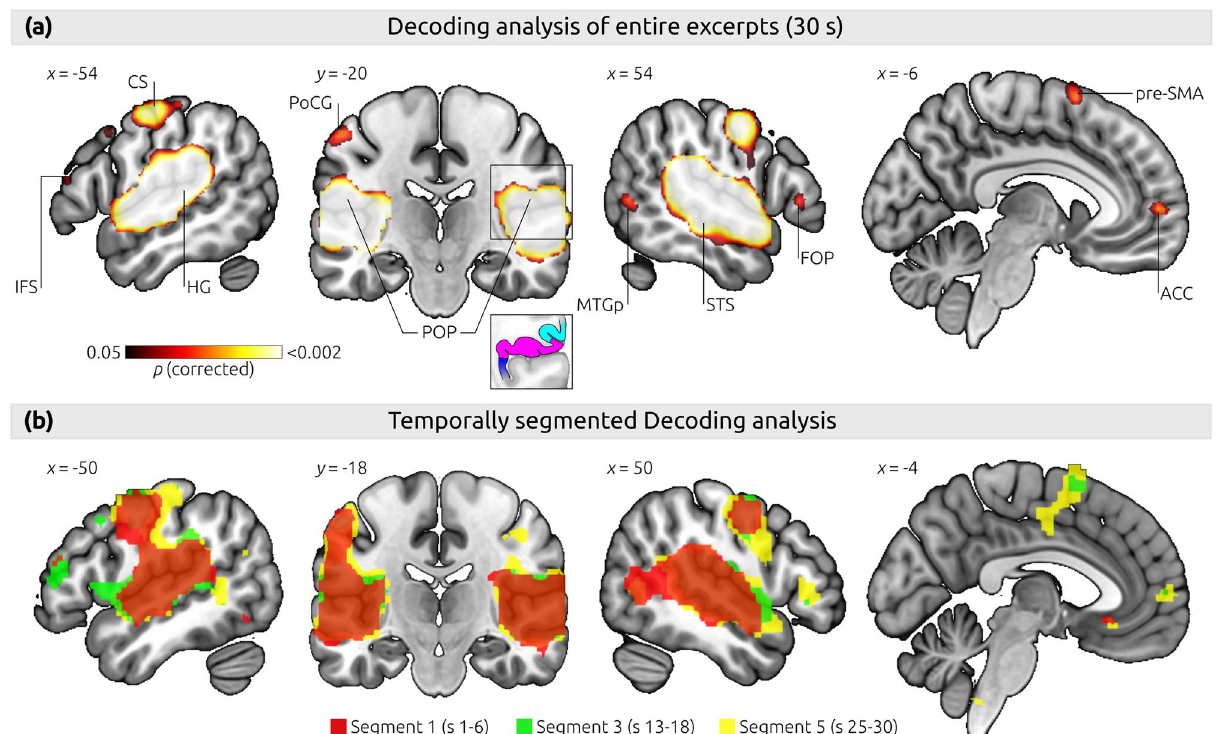
Figure 2. Results of the decoding analysis, showing clusters with voxels providing significant information about the difference between joy- and fear-music (after permutation-based t -tests and correction for multiple comparisons, all results were obtained without spatial smoothing, and statistical significance was computed on the voxel level). Results shown in the upper panel (a) were obtained using the entire duration of each music stimulus (each stimulus had a duration of 30 s). Significant clusters were found in the auditory cortex (including the superior temporal gyrus and superior temporal sulcus), posterior insular cortex, secondary somatosensory cortex (parietal operculum), primary somatosensory cortex and premotor cortex (post- and precentral gyrus as well as pre-SMA), frontal operculum and inferior frontal sulcus, as well as the ACC. The square in the coronal view indicates the area of the inset underneath; the inset illustrates anatomical boundaries between insula cortex (blue), cortex of the parietal operculum (magenta), and inferior parietal cortex (cyan), according to Ref. 50 . Note that the acoustical features that differed between joy and fear stimuli were entered as regressors of no interest in the data analysis, to reduce the influence of acoustical differences between the stimuli on the results. The lower panel (b) shows the temporally segmented results, for the beginning of excerpts (first 6 s, red), middle of the excerpts (seconds 13 to 18, green), and the end of excerpts (seconds 25–30, yellow). Note that, in each cluster, the cluster-size increased from the beginning to the end of excerpts, corroborating the findings of the main decoding analysis. ACC anterior cingulate cortex; CS central sulcus; FOP frontal operculum; HG Heschl’s gyrus; IFS inferior frontal sulcus; MTGp posterior middle temporal gyrus; PoCG postcentral gyrus; POP parietal operculum; pre-SMA pre-supplementary motor area; STS superior temporal